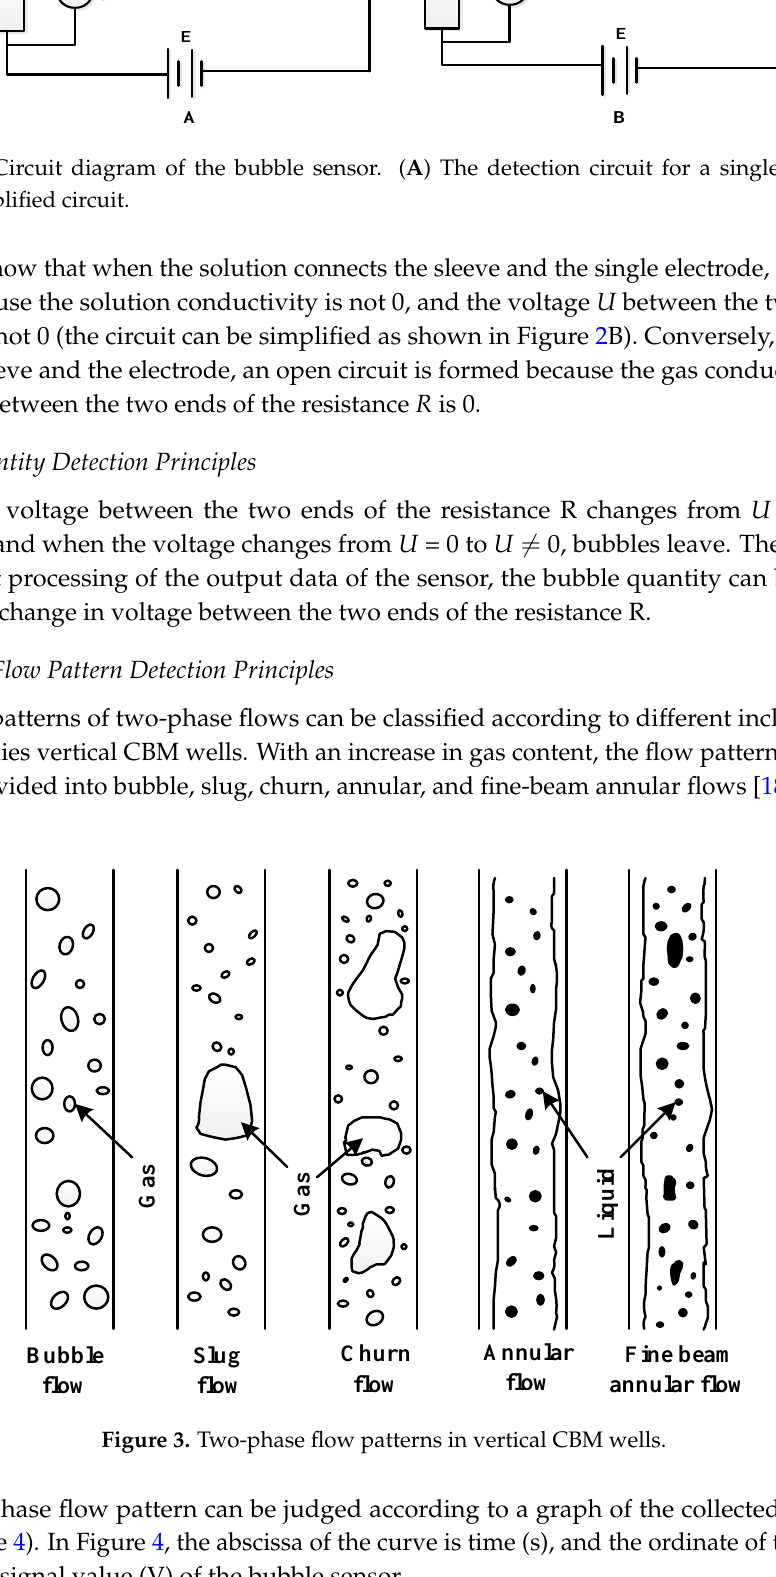
Figure 1. Schematic diagram of the structure of the bubble detection sensor.